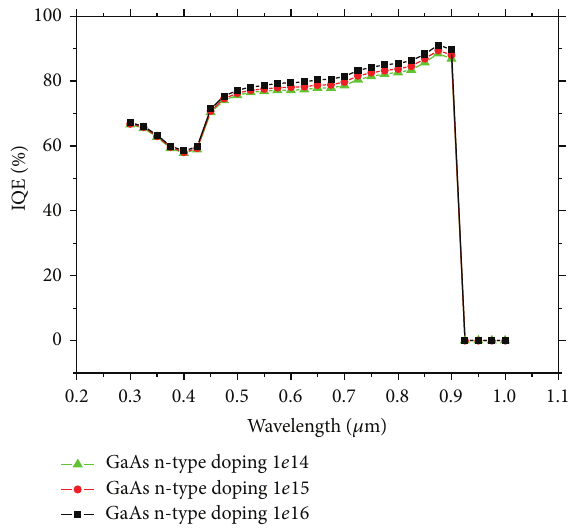
Figure 9: IQE of graphene GaAs solar cells versus n-type doping